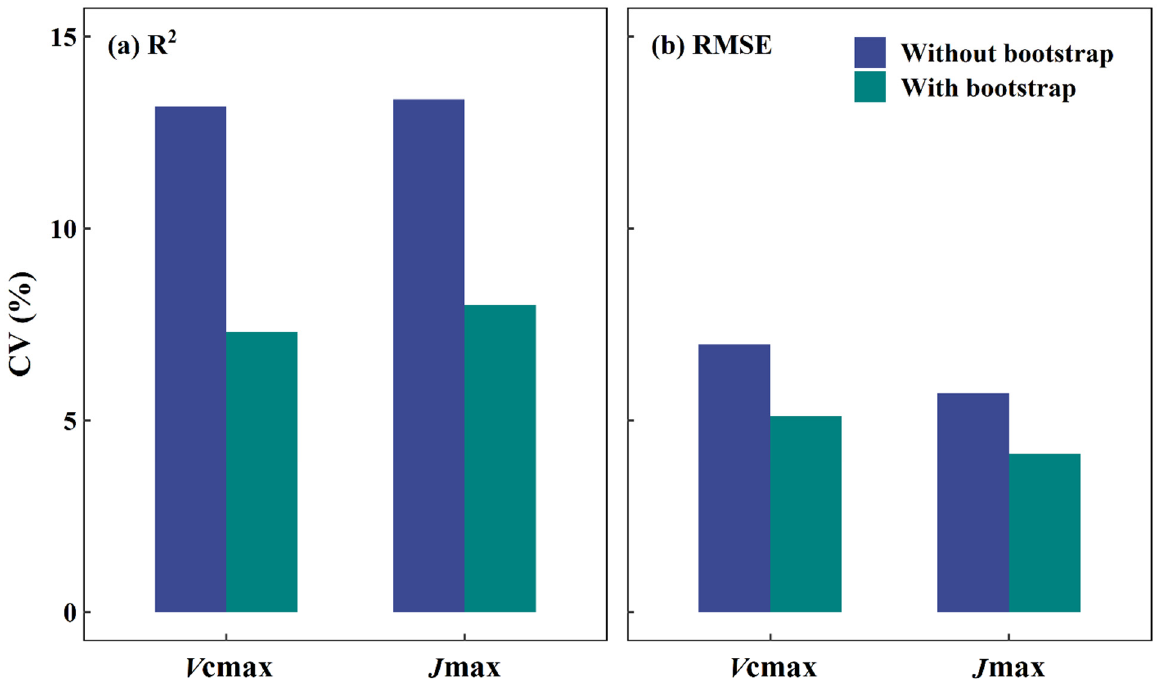
Figure 5. The coefficient of variation (CV) for the coefficient of determination (R 2 ) ( a ) and root mean square error (RMSE) ( b ) for predicting the maximum carboxylation rate ( V cmax) and maximum electron transport rate ( J max) using the DNN model without and with the bootstrap sampling approach.